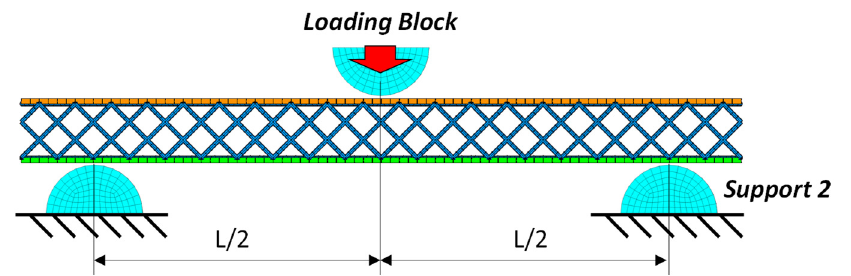
Figure 3. Applied boundary conditions by modelling the metallic support and the loading block.